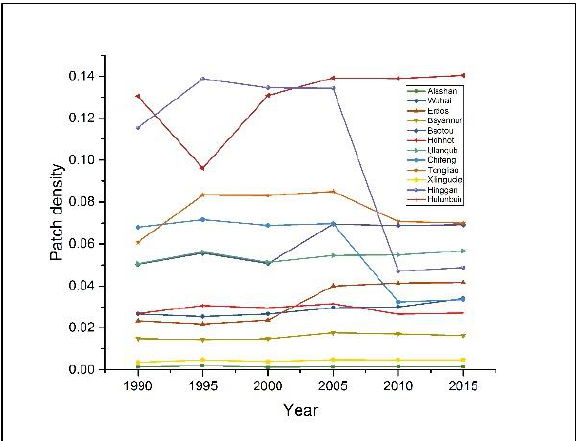
Figure 6. Patch density of cities in Inner